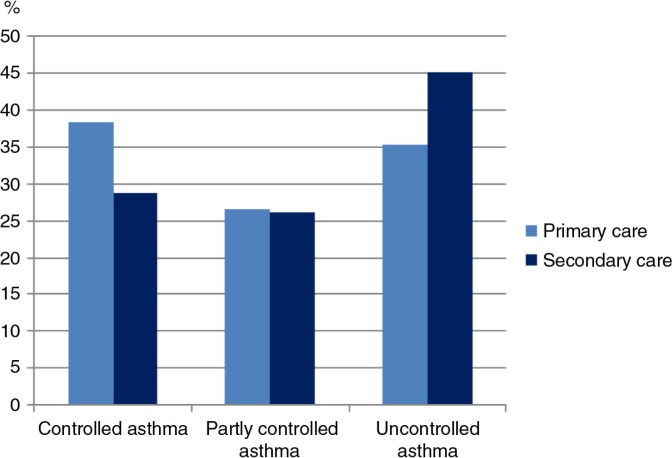
Asthma control in primary and secondary care (<0.0001).